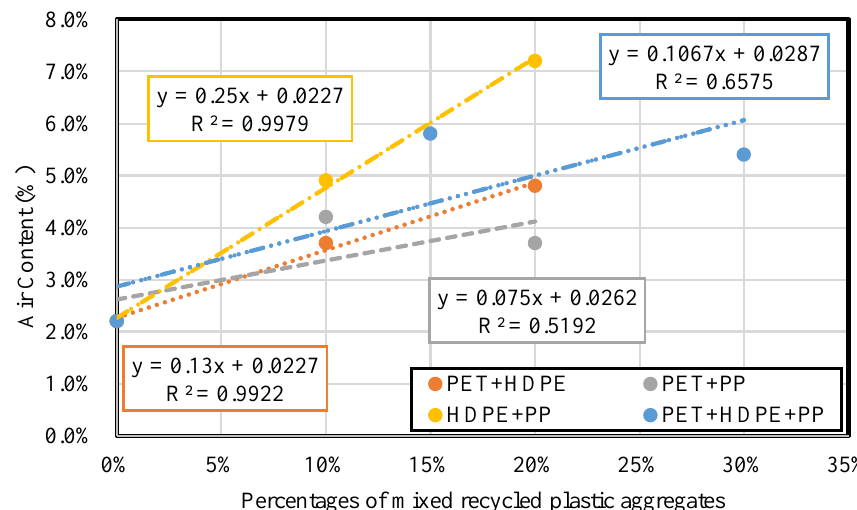
Figure 6. Variation of air content with mixed plastic replacement percentages.